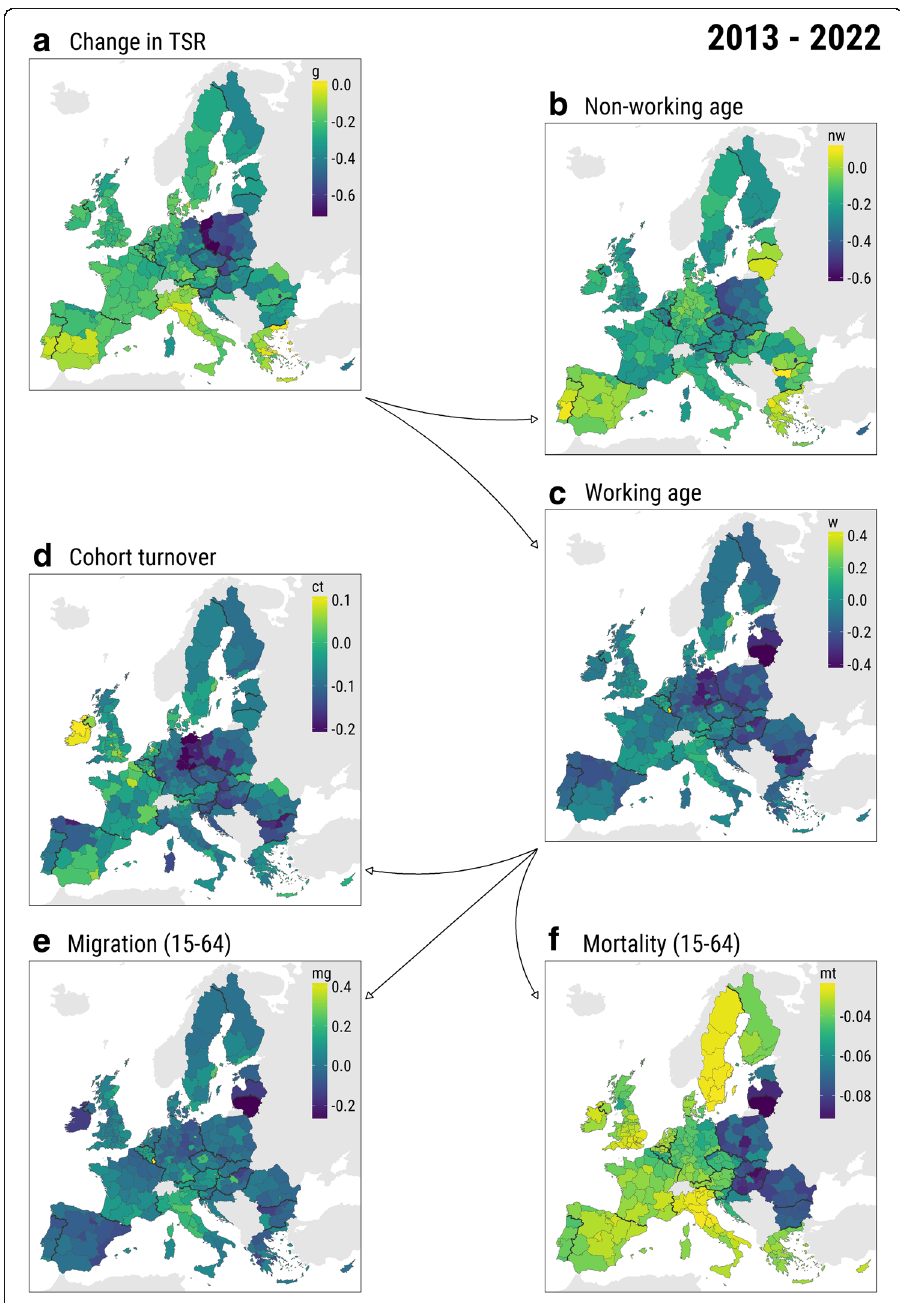
Fig. 7 Decomposition of change in TSR between 2013 and 2023. Notes : a Overall change. b Change due to dynamics in non-working-age population. c Change due to dynamics in working-age population. d Change due to cohort turnover. e Change due to migration at working ages. f Change due to mortality at working ages. Color scales are panel specific due to the big difference in variables ’